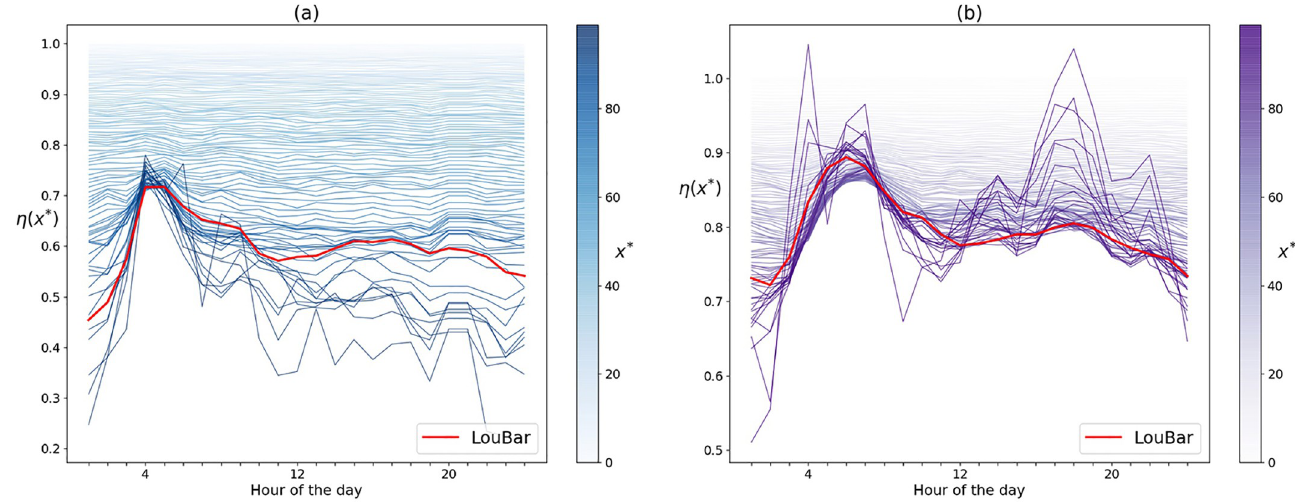
Fig 10. Spreading indices over time for various thresholds ~ x � in (a) Rome and (b) London.